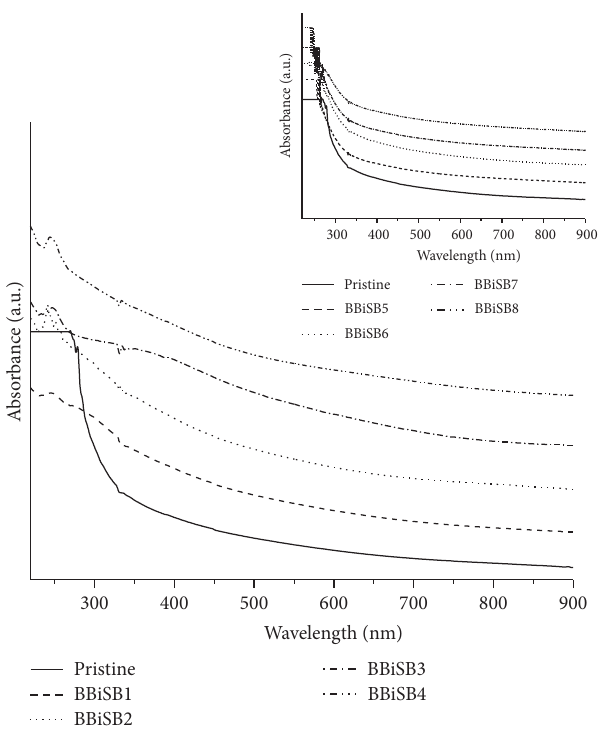
F6:ShowingtheUV-VisspectraofBBiSB-glassseriesthin�lm samples before and aer irradiation with Ag spectra of the same glass samples irradiated with Li